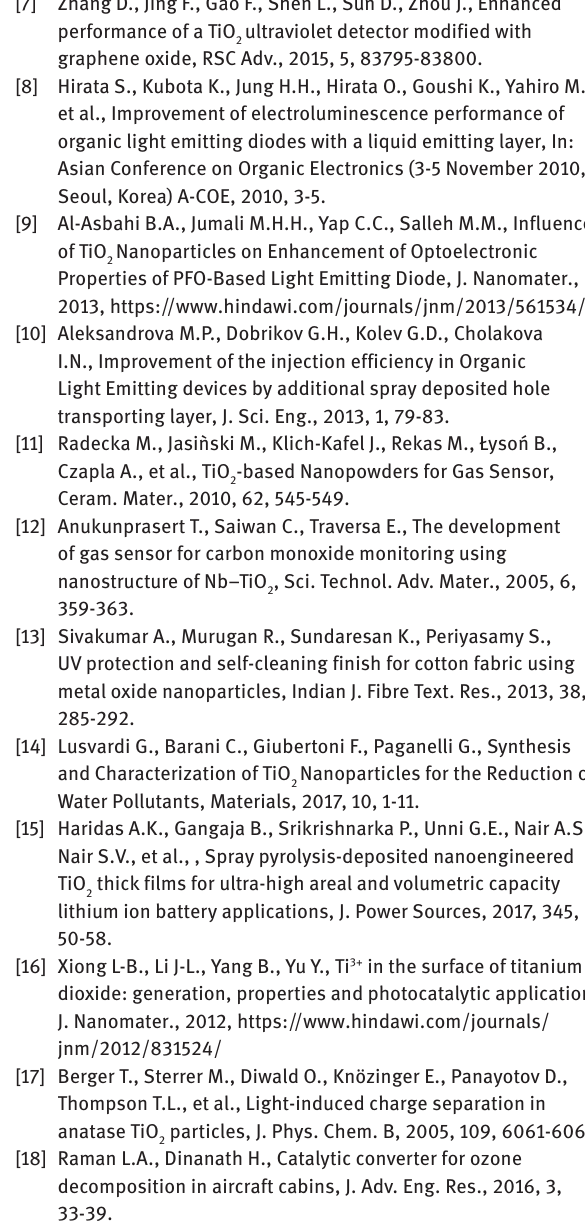
Fig 6. SEM images of bilayer TiO 2 films (a) 1000 KX (b) 300 KX (c) 100 KX